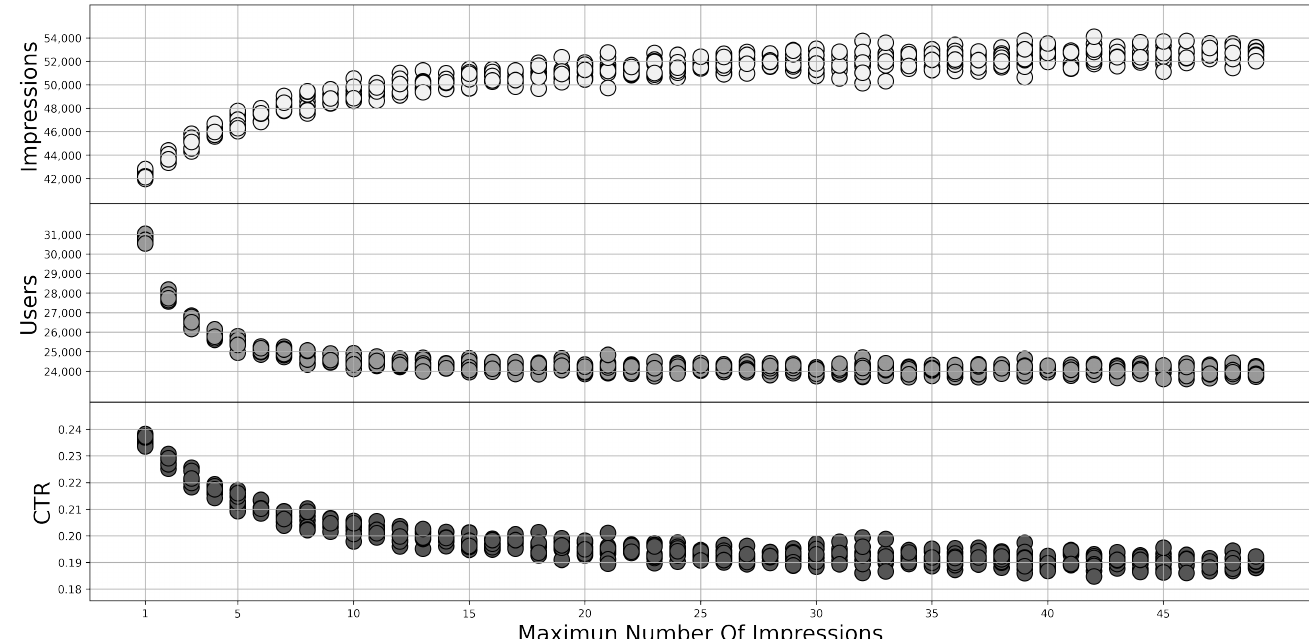
Figure 12. The figure shows the evolutions of impressions, clicks, and CTR for the simulated cases as we change the maximum impressions capping. All simulations are based on an target of reaching 10k